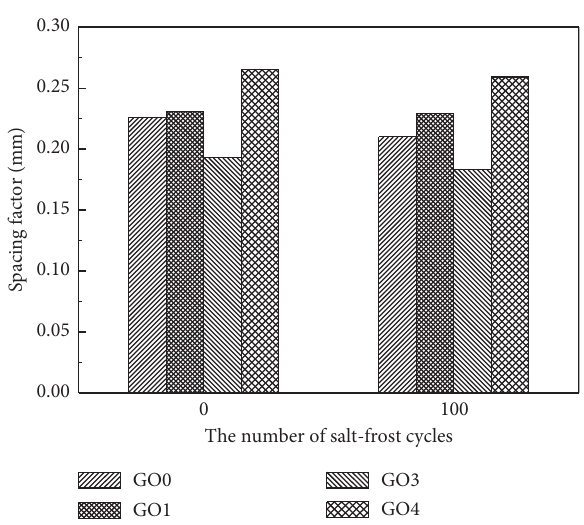
Figure 8: Bubble spacing coefficients of GO concrete.